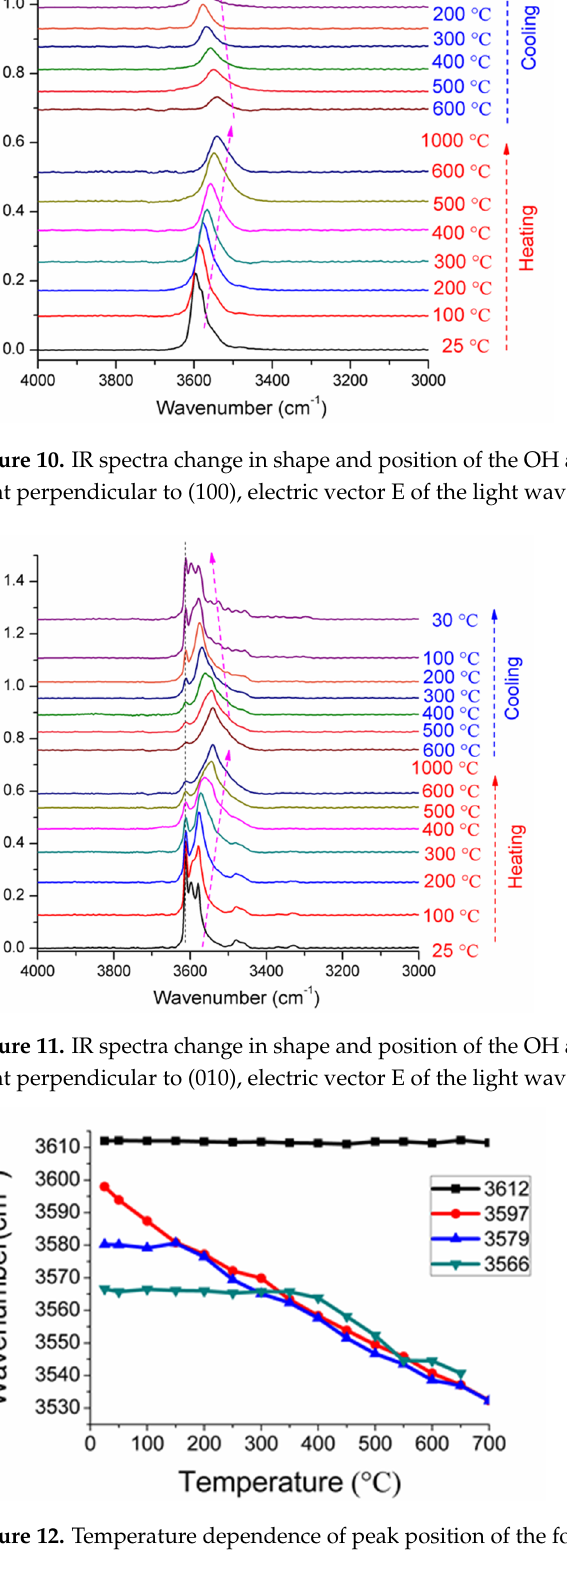
Figure 12. Temperature dependence of peak position of the four types of structural OH of forster-